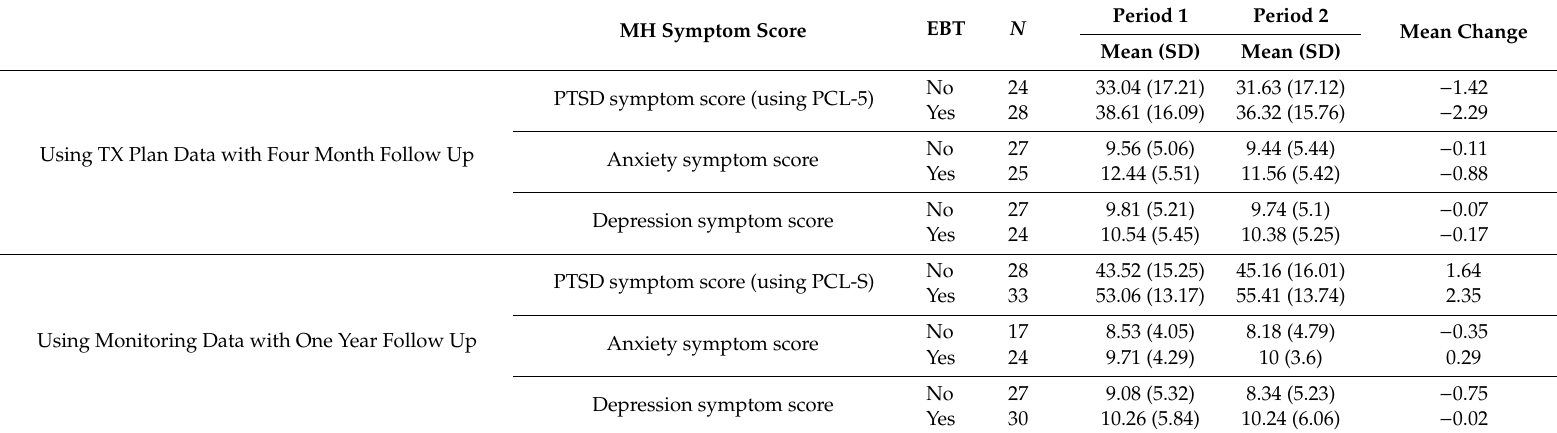
Table 3. Mental health symptom scores at review 1 and review 2 compared by study